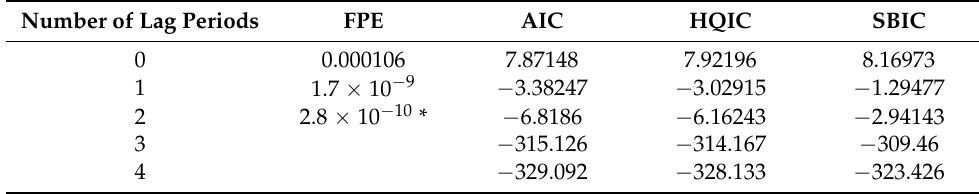
Table 4. SVAR model’s optimal lag period decision test. Number of Lag Periods FPE AIC HQIC SBIC